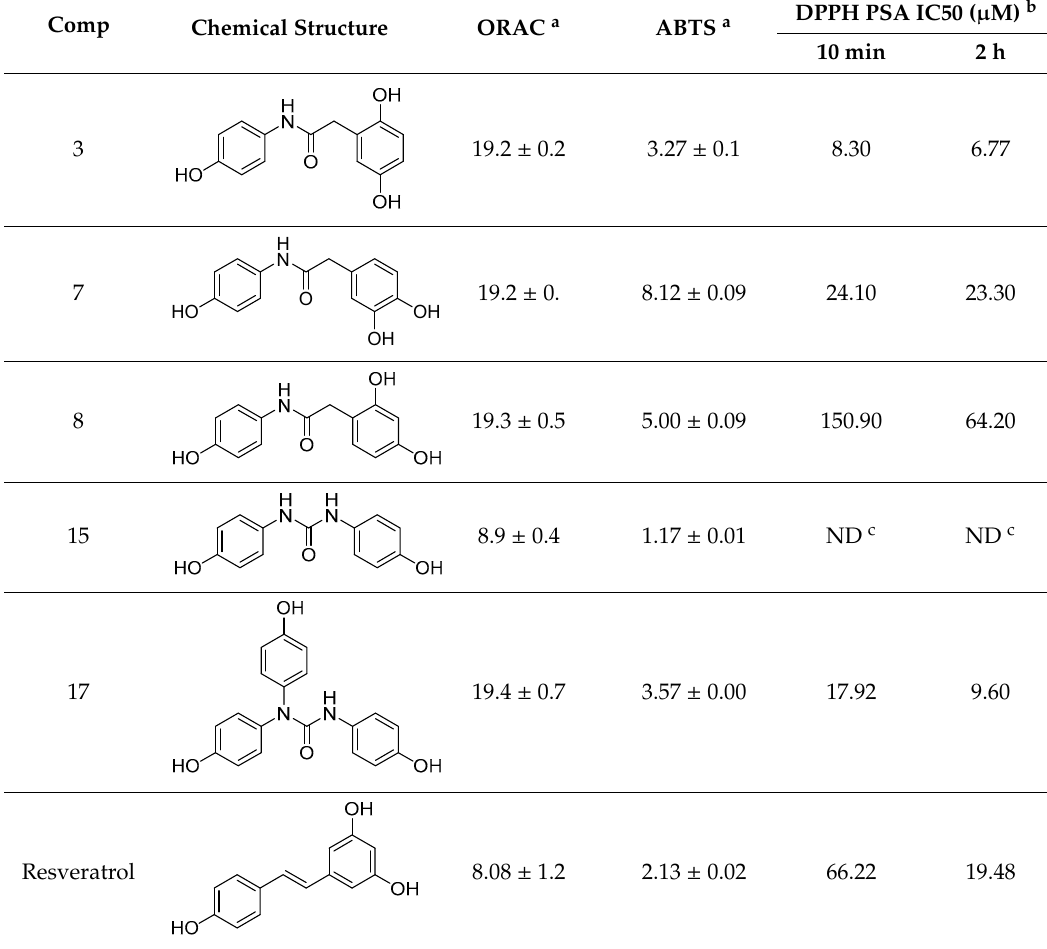
Table 4. Antioxidant profile of selected stable compounds. Table 4 . Antioxidant profile of selected compounds. Table 4 . Antioxidant profile of selected compounds. Table 4 . Antioxidant profile of selected compounds. Table 4 . Antioxidant profile of selected compounds. Table 4 . Antioxidant profile of selected compounds. Table 4 . Antioxidant profile of selected compounds.